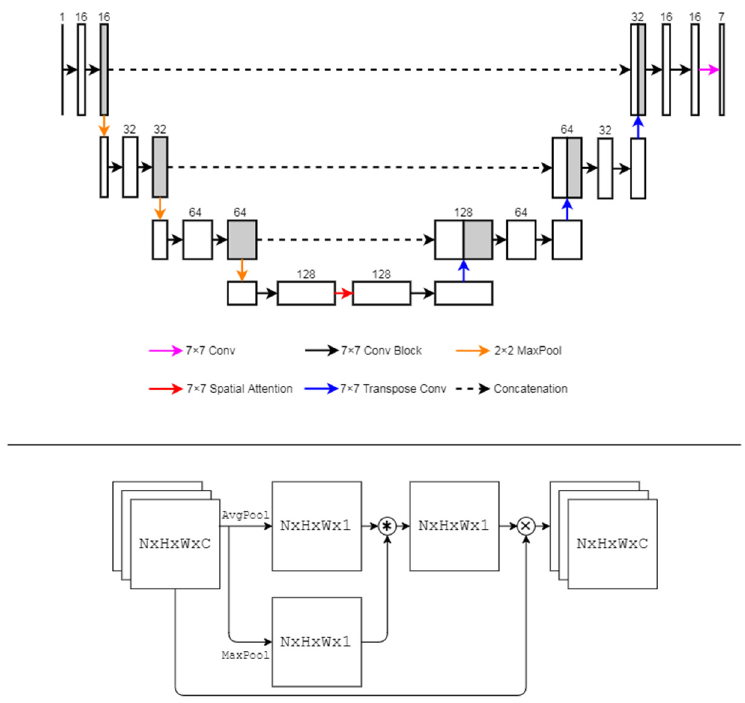
Figure 4. The architecture of